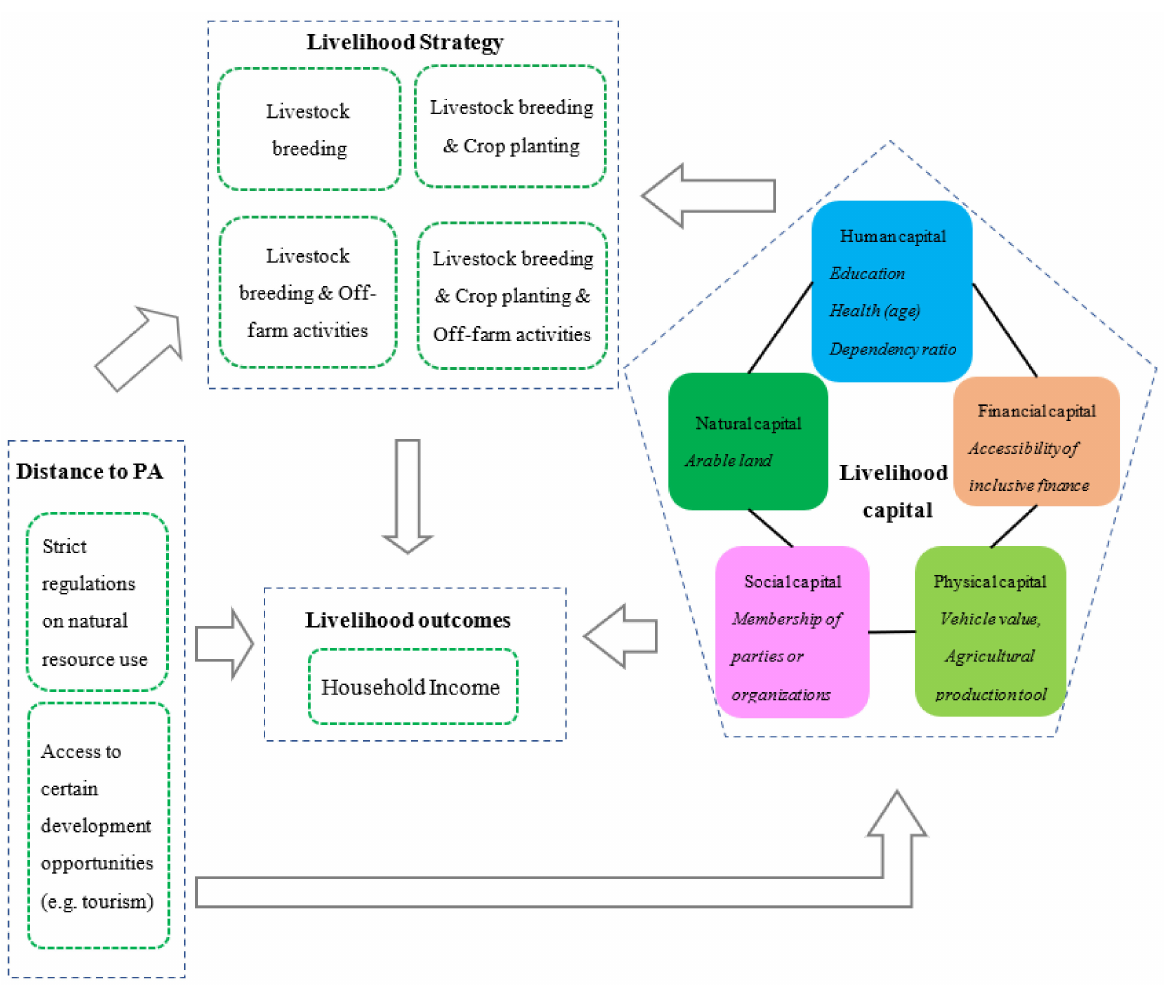
Figure 1. Conceptual framework of this